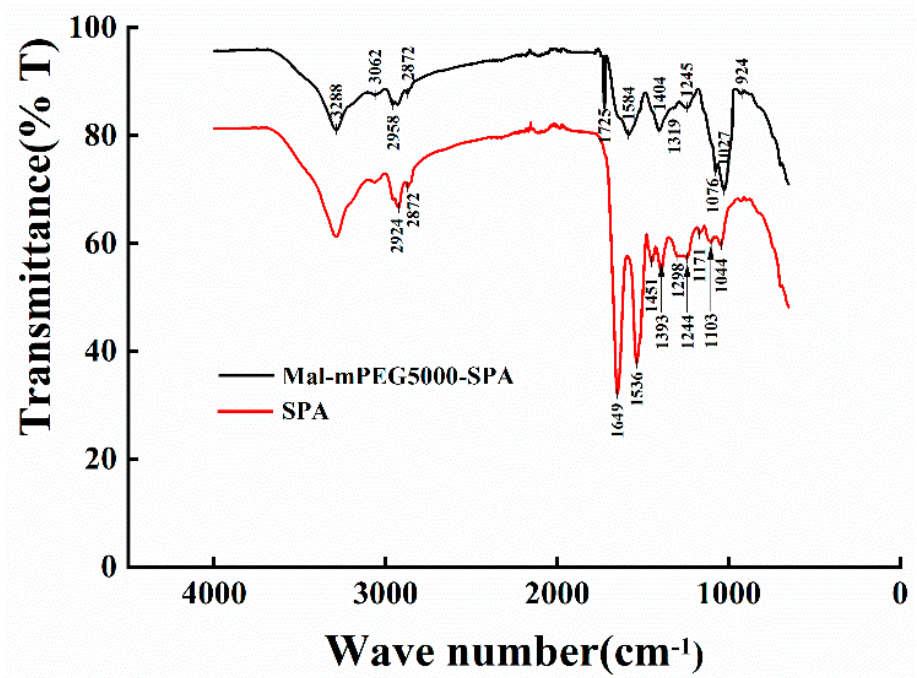
Figure 1. Infrared spectra of SPA and Mal-mPEG5000 − SPA.